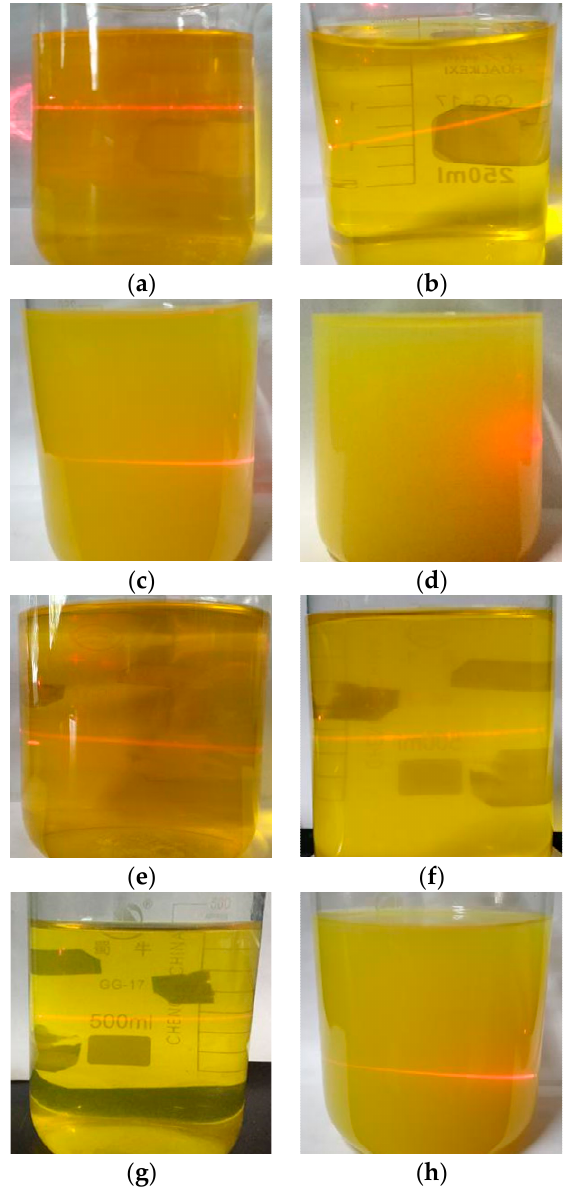
Figure 2. The state of the sol doped with Ni aged for varying times. ( a ) 0% Ni, 1 h; ( b ) 0% Ni, 18 h; ( c ) 0% Ni, 39 h; ( d ) 0% Ni, 63 h; ( e ) 1% Ni, 1 h; ( f ) 1% Ni, 18 h; ( g ) 1% Ni, 39 h; ( h ) 1% Ni, 63 h.